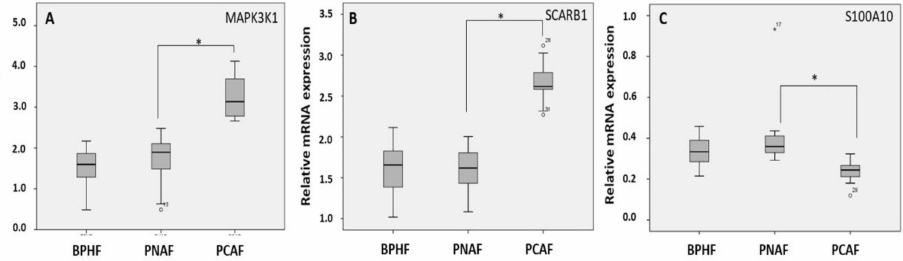
Figure 3. Validation of the deregulated genes derived from microarray analysis. Expression of MAP3K1 ( A ), SCARB1 ( B ), and S100A10 ( C ) expression in PCAF compared to PNAF derived from adjacent tumor tissues and BPHF derived from tumor-free prostate tissues. Gene expression was evaluated by qRT-PCR analysis. The values shown are the 2 − ∆∆ Ct ratios of the difference between cycle thresholds ( ∆ Ct) of the corresponding marker genes and the housekeeping gene TBP; n = 3 independent differentiation experiments * p ≤